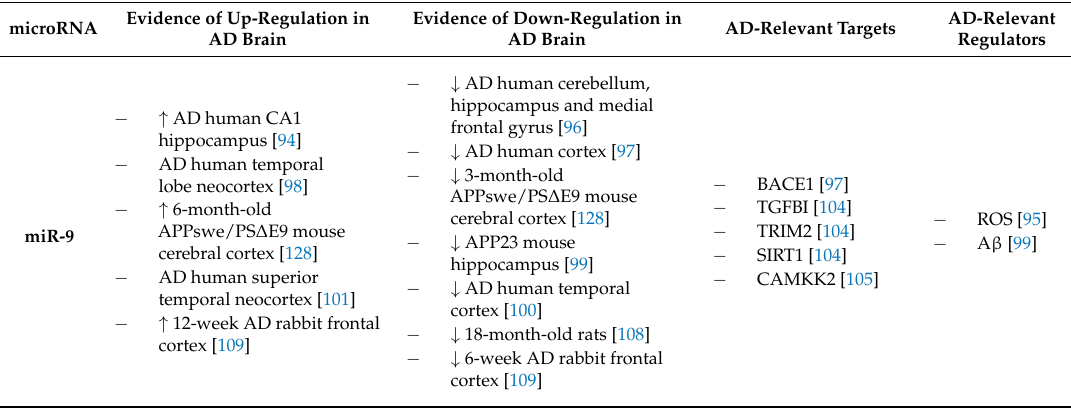
Table 1. microRNA Expression Profiles, Targets, and